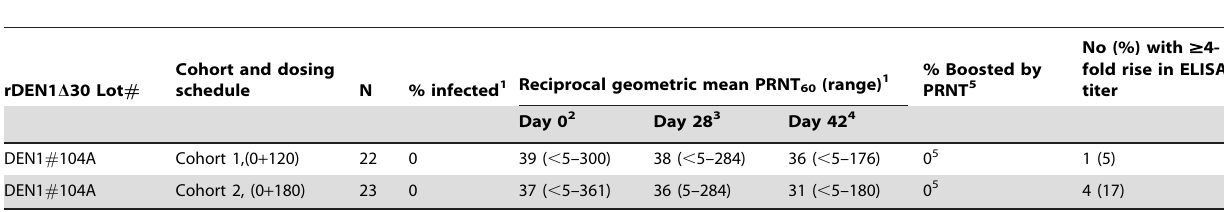
Table 5. Serum antibody response induced by a second 10 3 PFU dose of rDEN1 D 30 given at 4 or 6 months after first dose.